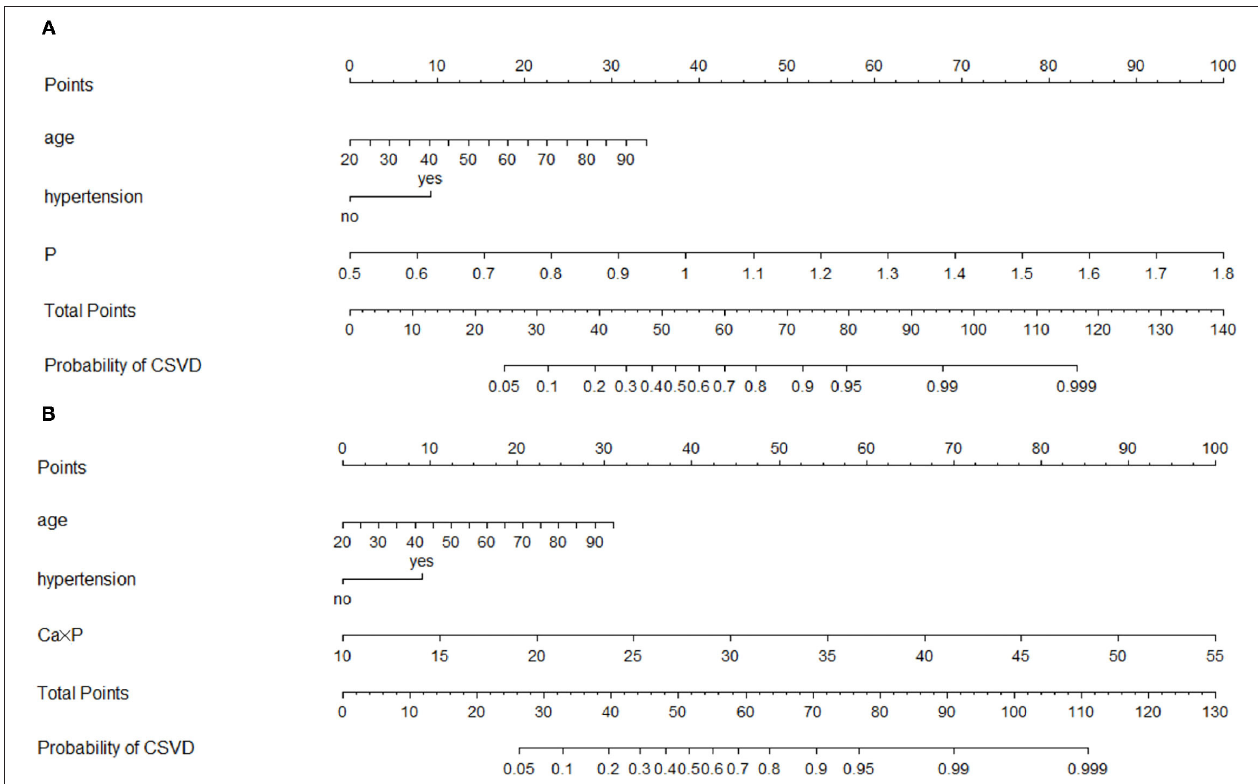
FIGURE 7 | Nomograms of models 2 and 3 for predicting the probability of CSVD. (A) Model 2; (B) Model 3.